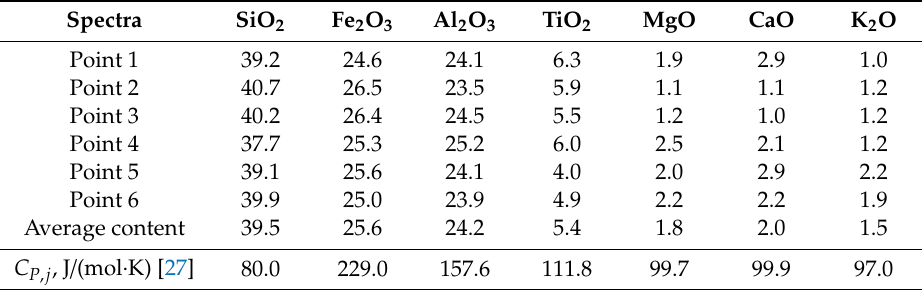
Figure 9. Energy Dispersive Spectrometer (EDS) analyze of sample B3. Table 4. Chemical composition of the glass phase in sample B3 and the partial molar heat capacity at 0.1 MPa/mol%.